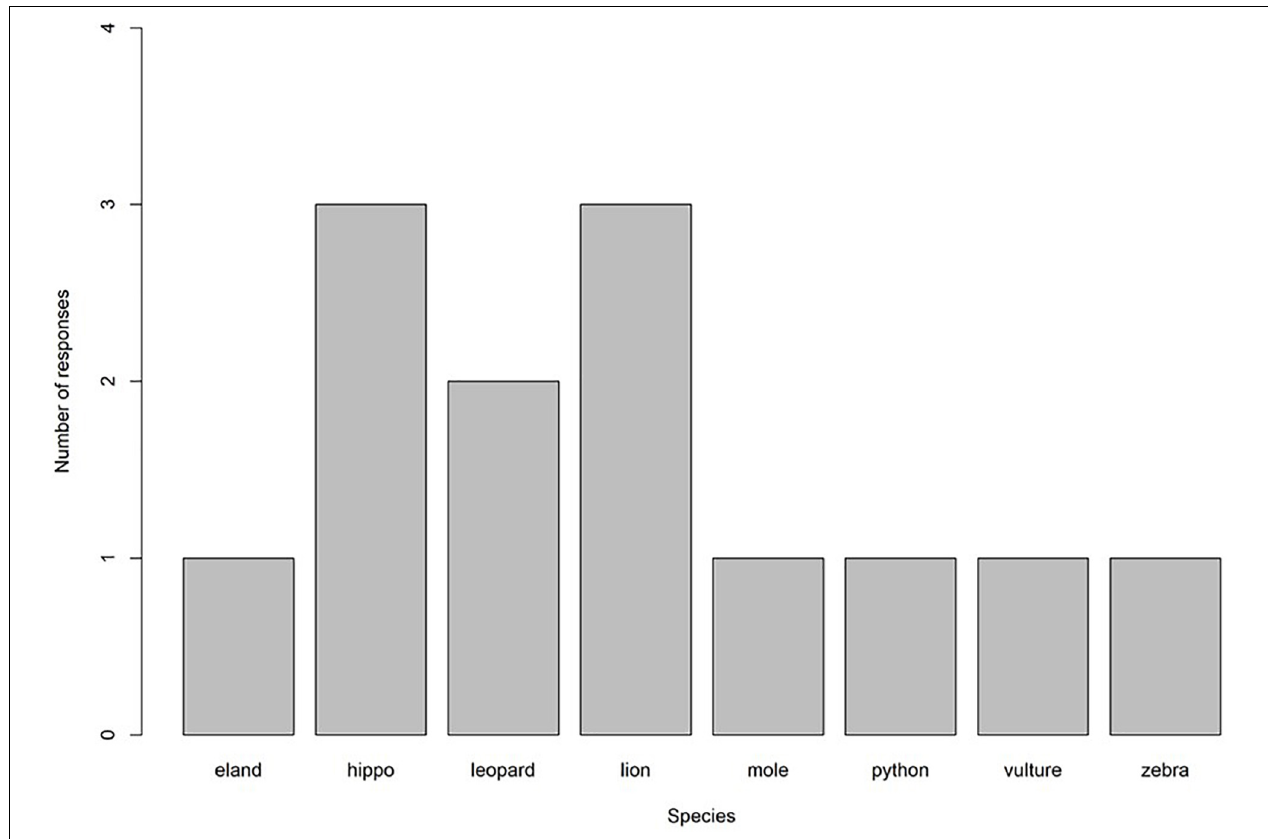
FIGURE 2 | Species common names mentioned ( n = 20) by five traditional healers when asked to name the most profitable derivatives they use in traditional medicine.